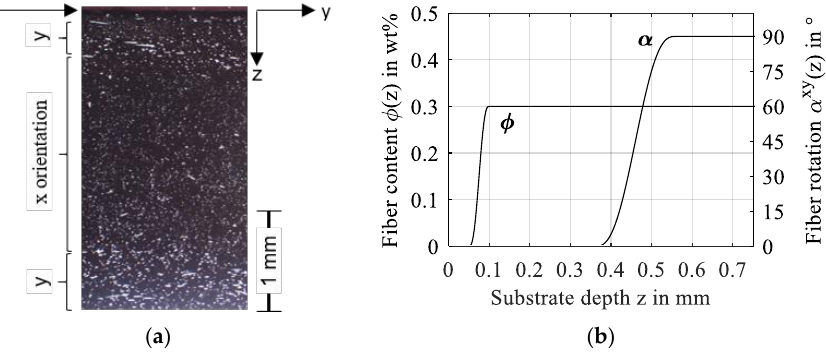
Figure 18. Cross-sectional microscopy of the fiber orientation in an injection-molded tribometer sample made of PA66 with 30 wt% glass fibers ( a ) and fiber content and orientation ( b ).